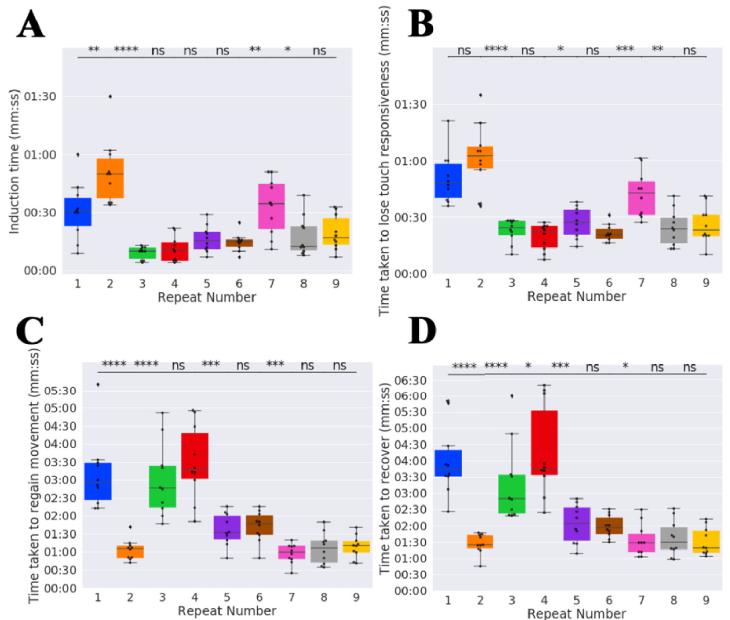
Fig 6. The time taken to induce, lose touch responsiveness, regain movement, regain equilibrium as well as respiratory rate varies within an acceptable range for fish repeatedly anaesthetised using protocol 4 every 2 days. Boxplot of (A) induction time, (B) time taken to lose touch responsiveness, (C) time taken to regain movement and (D) time taken to recover. Stars indicate significant difference of subsequent repeats as determined using the Mann- Whitney U test. ns = not significant, ‘ � ’ indicates p < 0.05, ‘ �� ’ indicates p < 0.01, ‘ ��� ’ indicates p < 0.001 and ‘ ���� ’ indicates p < 0.0001.